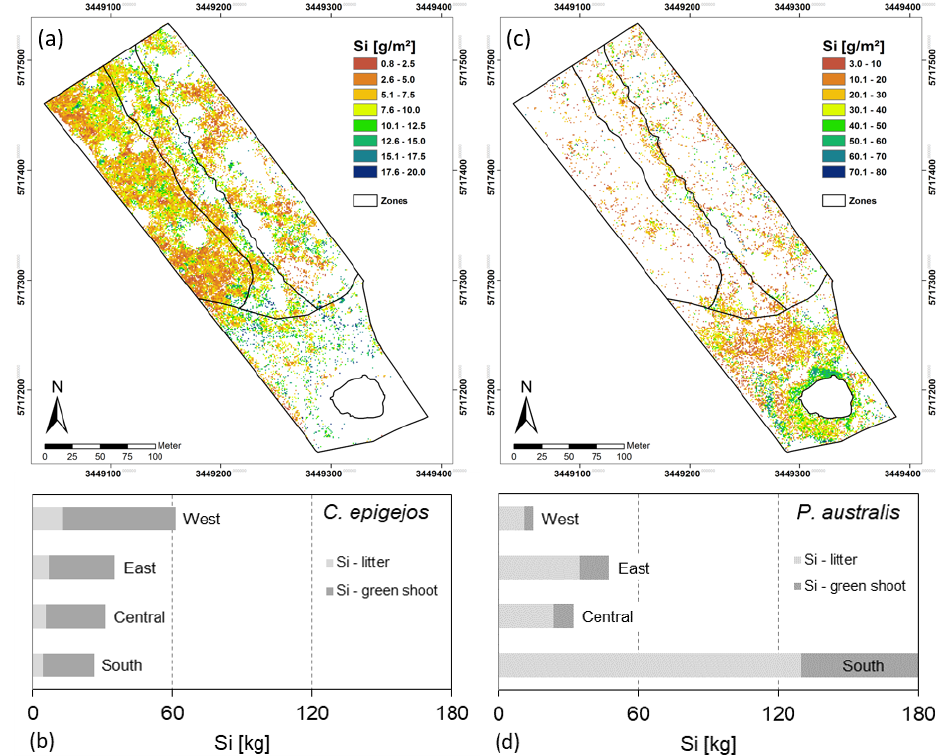
Figure 8. Spatial distribution of Si stocks of C. epigejos (a) and P. australis (c) and total amounts of Si accumulated in the four zones by C. epigejos (b) and P. australis (d) . Note the different legend scales in (a) and (c) .